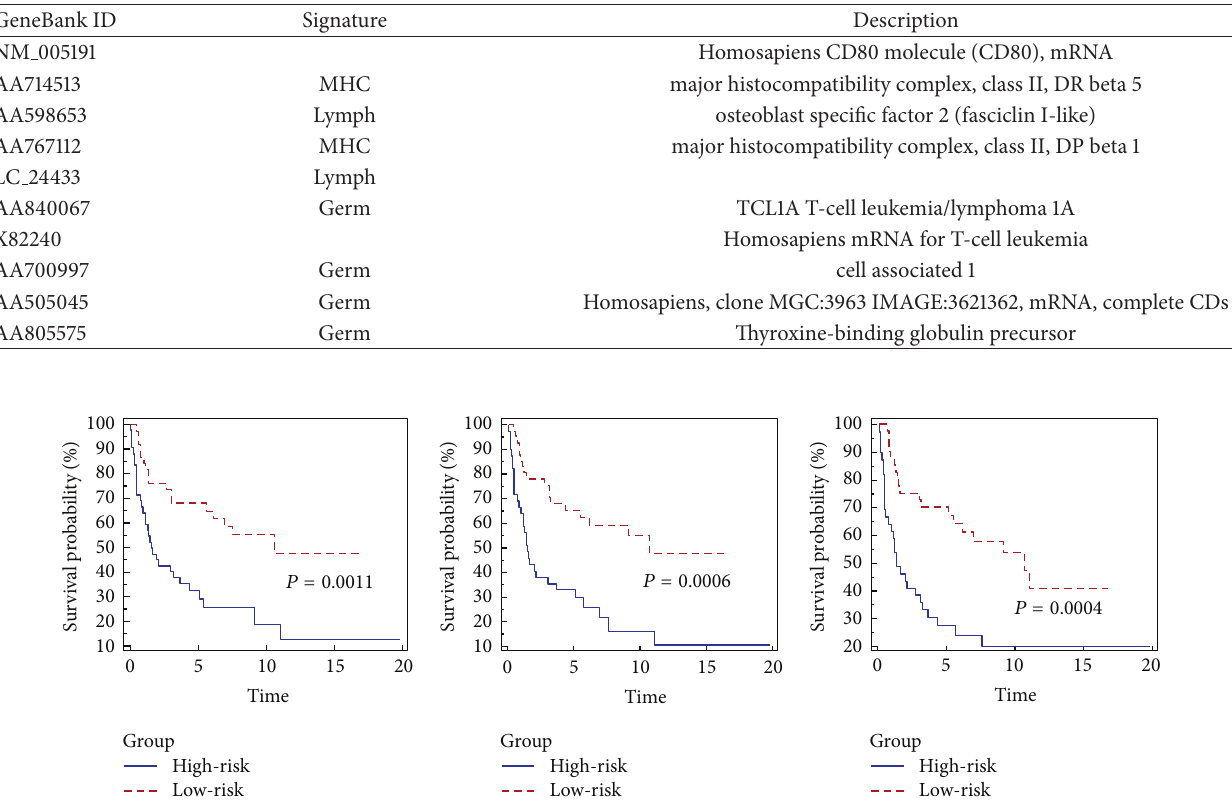
Table 2: GeneBank ID and descriptions of the top 10 genes selected by the adaptive L 1/2 shooting regularization method based on the 160 patients in the training dataset. Indicated are the gene expression signature groups that these genes belong to; Germ: Germinal-center B-cell signature, MHC: MHC class II signature, and Lymph: lymph-node signature. Genes NM 005191 and X82240 do not belong to these signature groups.